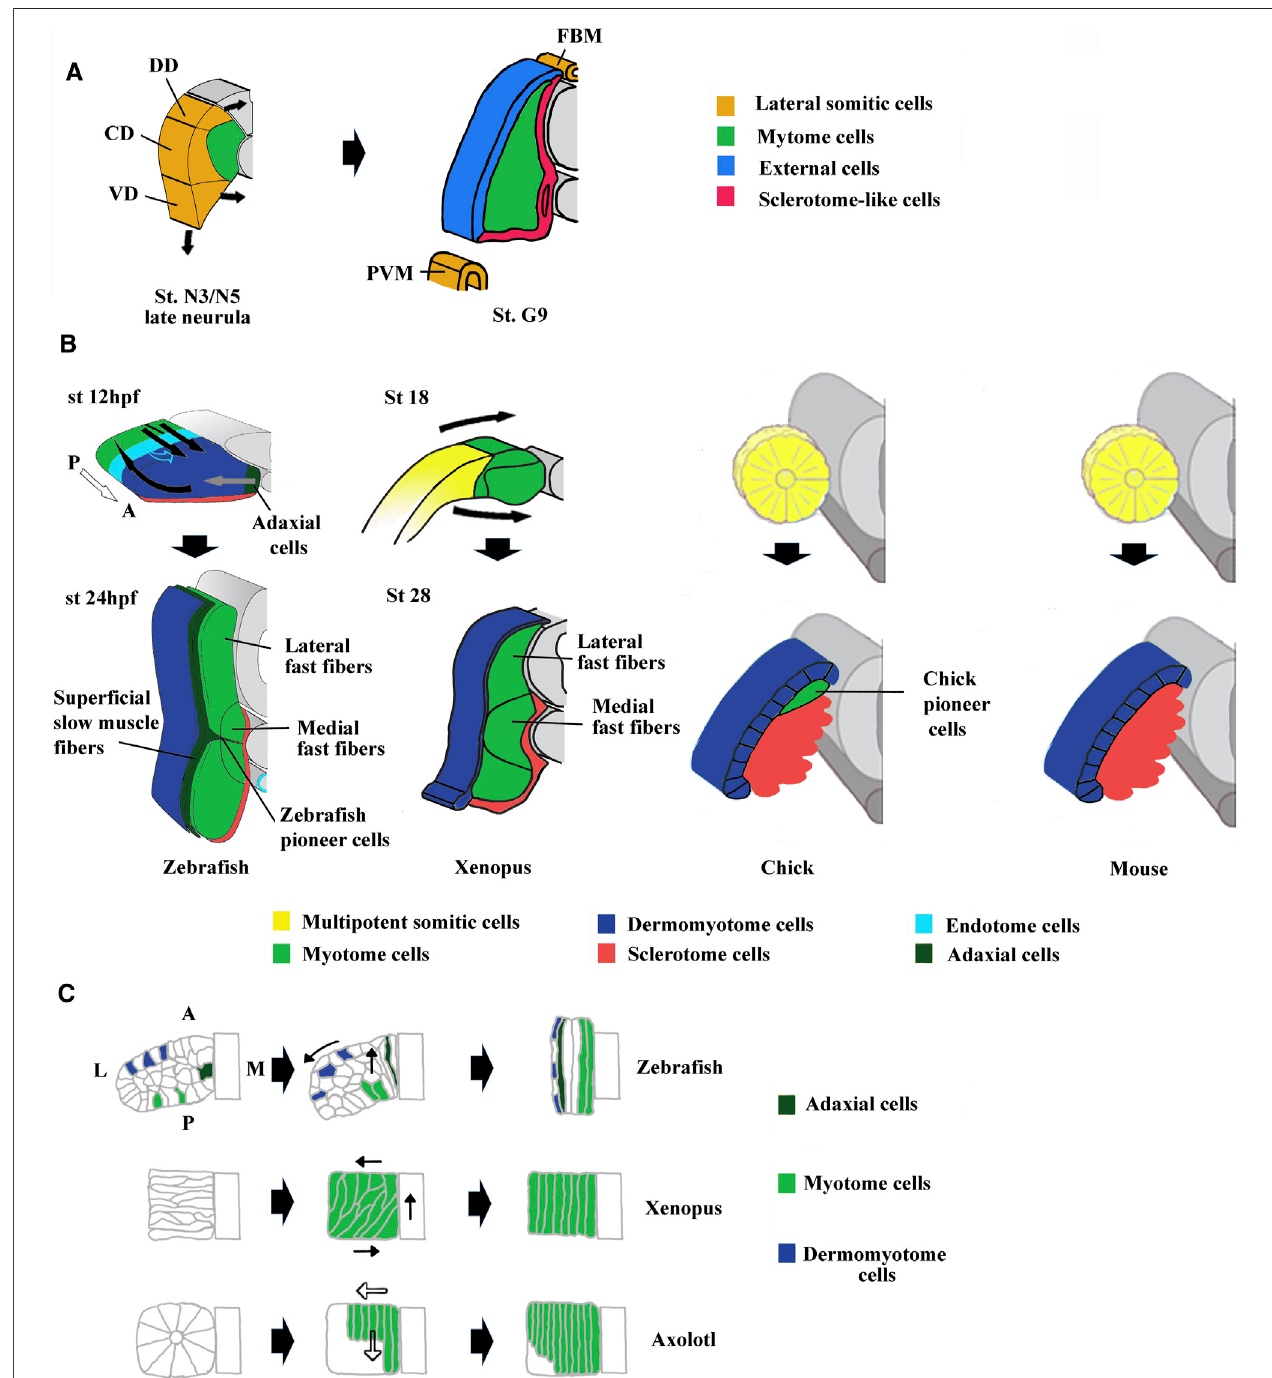
FIGURE3 | Comparison ofcompartmentalization modes between amphioxus, zebra fi sh, Xenopus , chick and mouse. (A) The lateral domain of amphioxus somite is already compartmentalized at mid neurula stage and possesses progenitors that give rise to the external cells layer, the sclerotome-like compartment but also the lateral plate mesoderm and the fi n box mesothelium at stage G9. The lateral domain can be subdivided into three subdomains which express different set of genes. For example, Pax3/7 is expressed in the central domain (CD), Pax1/9 in the dorsal domain (DD) and Hand in the ventral domain (VD). Adapted from Yong et al. (2021). (B) The fi rst phases of compartmentalization are both medio-lateral and antero-posterior in zebra fi sh, mainly medio-lateral in Xenopus and mainly dorso-ventral in chick and mouse. In zebra fi sh, an apparent movement of somite rotation relocated the different cell populations during the segmentation period. The posterior cells elongate toward the anterior region of the somites (straight black arrows) and give rise to fast fi bers, the anterior cells were relocated in the surface outside of the somites (curved black arrows) and give rise to the dermomyotome. In addition, the medially adaxial cells migrate laterally toward the myotome periphery (grey arrows) and differentiate